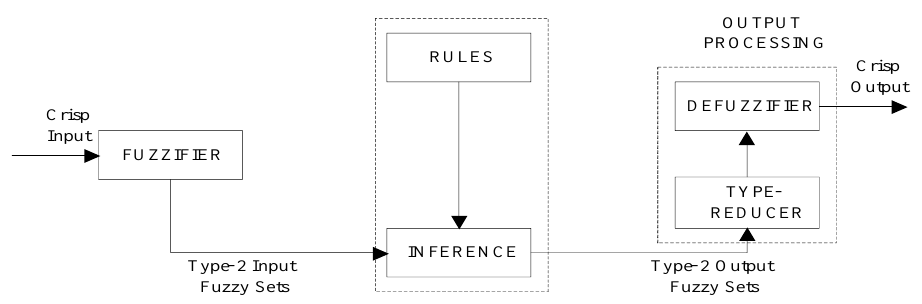
Figure 3. Structure diagram of the IT2-fuzzy model (FM).